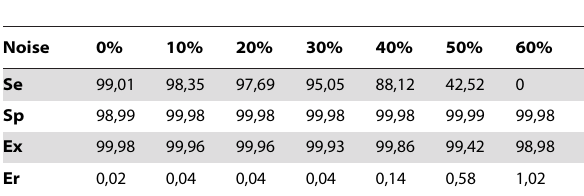
Table 1. Correlation s tatistical indexes